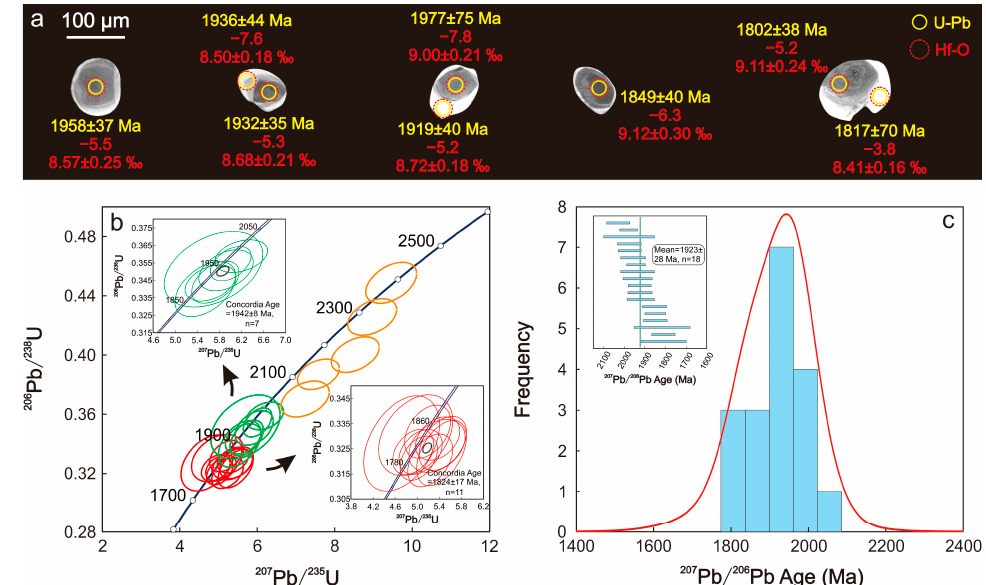
Figure 4. Zircon U-Pb isotopic analytical results of the Sanchakou gabbros from the Jining terrane. ( a ) Typical zircon CL images, marked with spot positions of in situ zircon U-Pb and Hf-O isotopic analysis; ( b ) The zircon U-Pb concordia diagram; ( c ) The 207 Pb/ 206 Pb age probability density histogram together with the 207 Pb/ 206 Pb weighted average age distribution. Table 2. The in situ zircon U-Pb isotopic data of the Sanchakou gabbros.